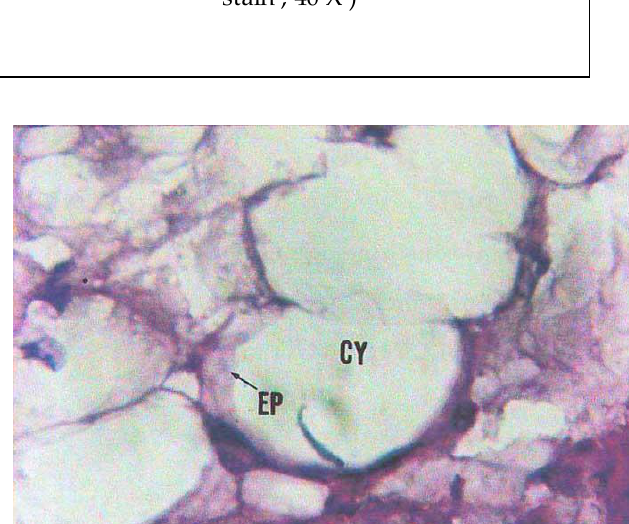
number of the vesicles (V) in the ultimobranchial gland of adult geese surrounding by stain , 40 X )